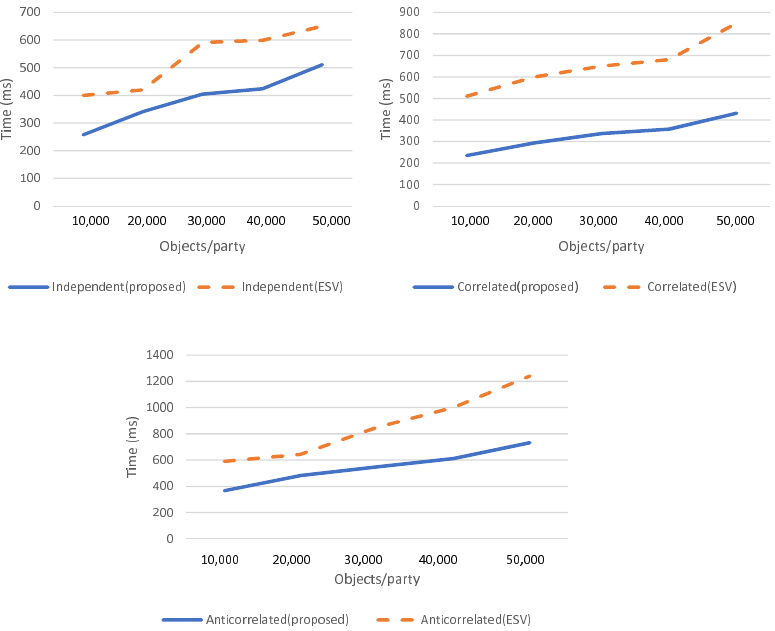
Figure 9. Running time comparison with ESVand the proposed method in different data distributions (attribute: 2, partitions: 30/attribute, value: 32-bit, bit-slice length: 11-bit, slices/attribute:3). ESV, encrypted substitution vector.